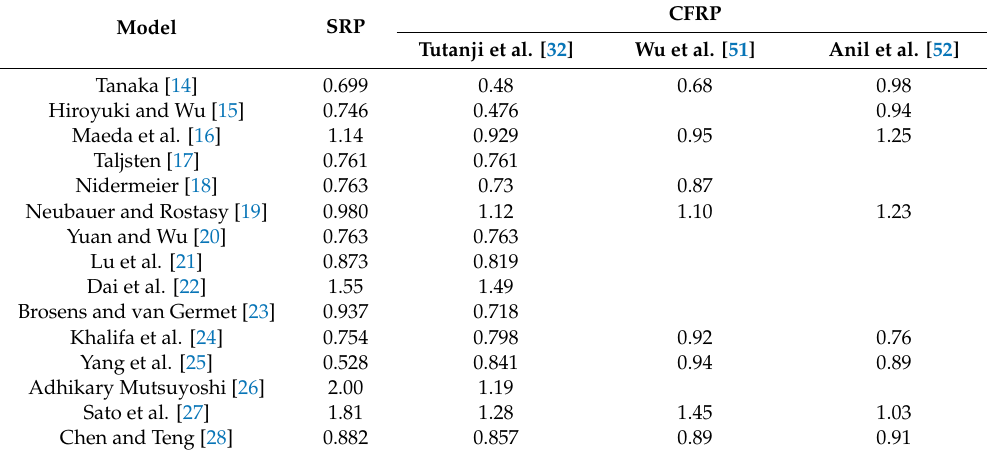
Table 7. Predicted to experimental bond strength ratios for SRP composites and carbon fiber reinforced polymer (CFRP) strips bonded to concrete.